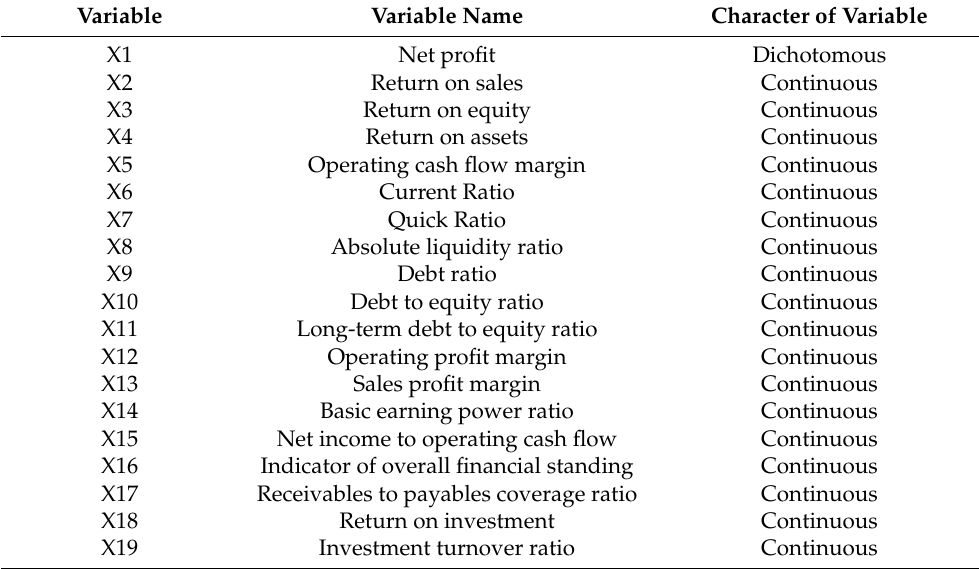
Table 3. Description of independent variables used in the